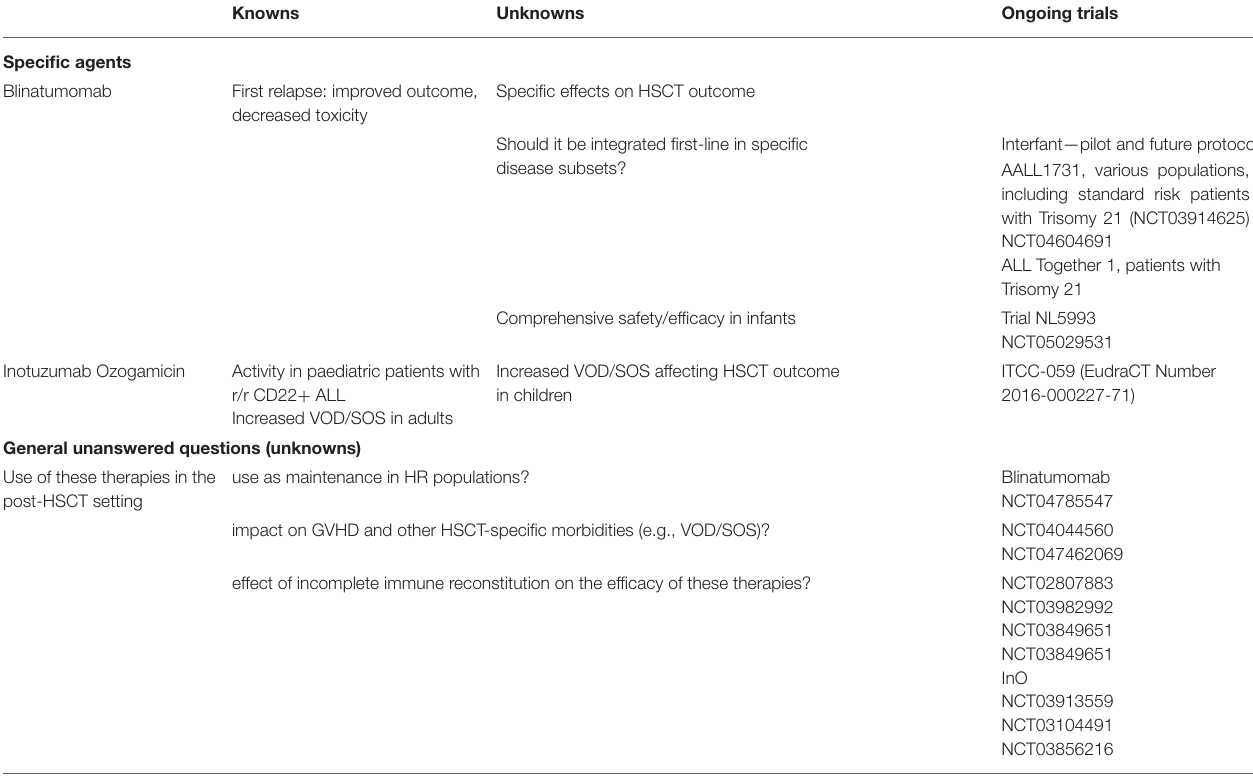
TABLE 1 | Knowns and unknowns with regard to various alternatives to traditional cytotoxic chemotherapy before or after HSCT for paediatric